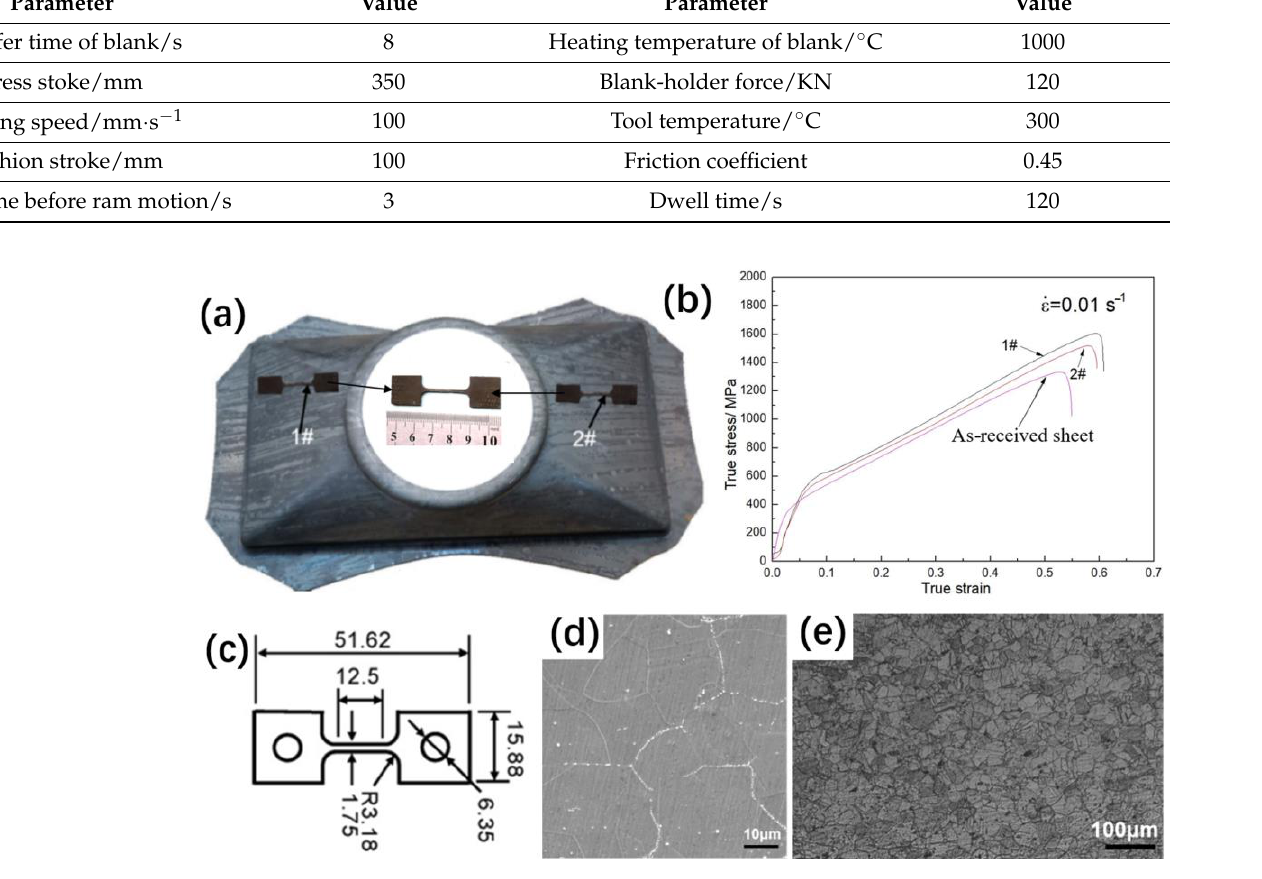
Figure 20. Mechanical properties and microstructure of the GH3625 stamping part: ( a ) stamped part and sampling locations; ( b ) true stress – strain curves; ( c ) 2D graph of tensile specimen; ( d ) SEM; ( e ) OM.